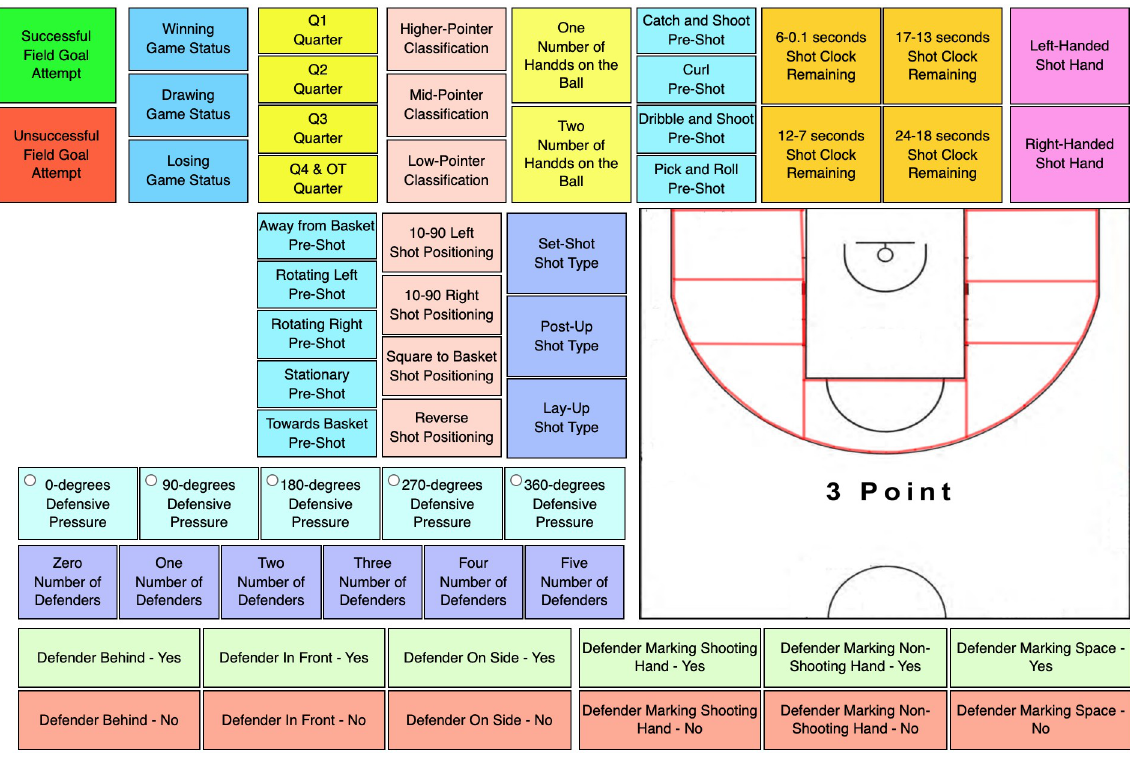
Fig 1. Field-goal attempt sports performance analysis template for wheelchair